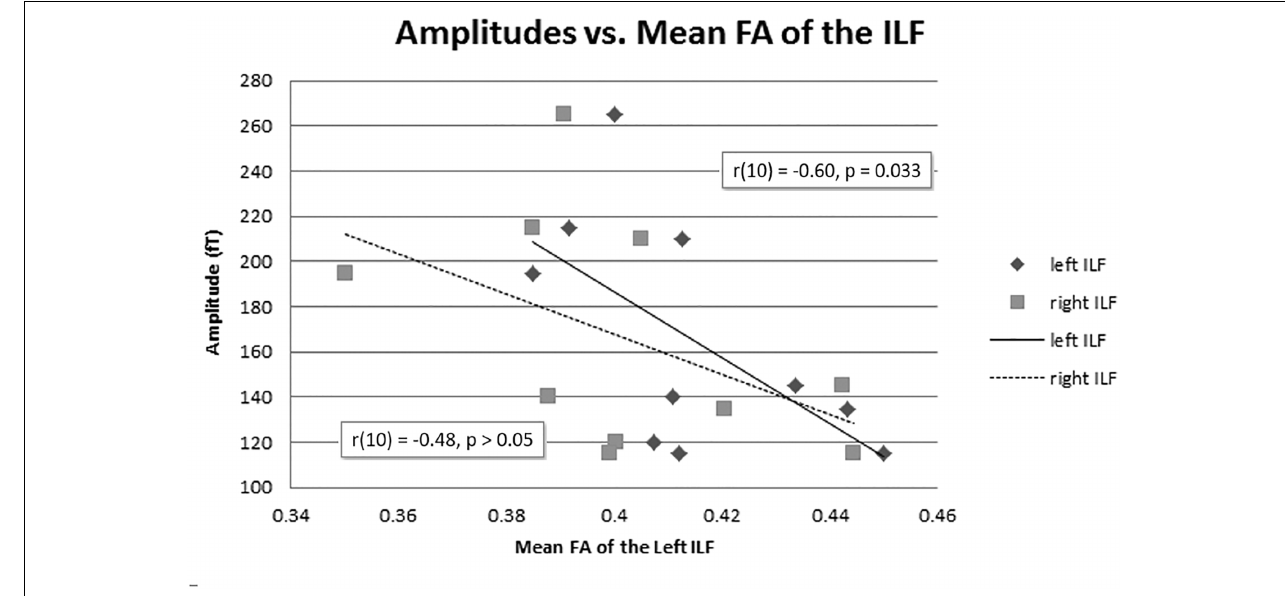
FIGURE 7 | N400m amplitudes and mean FA of the ILF. A negative correlation between N400m peak amplitude and mean FA of the left ILF has been identified [ r (10) = –0.60, p = 0.033, R 2 = 0.36]. The right ILF did not show a significant correlation with N400m peak amplitude ( p =